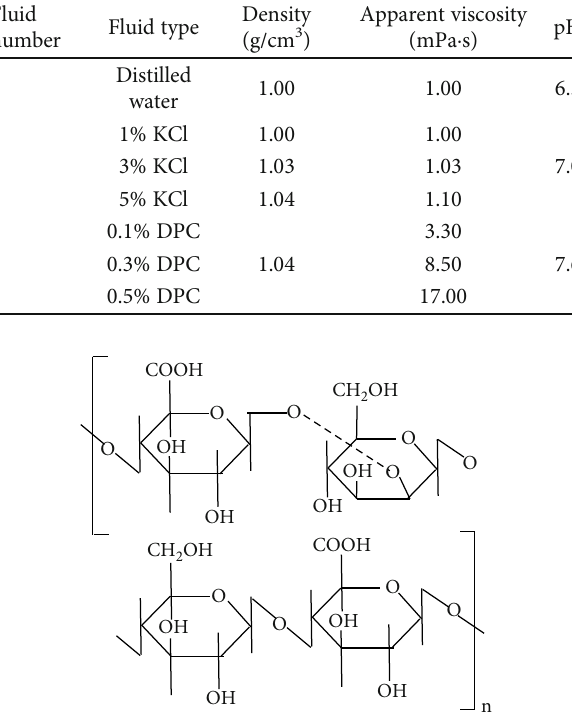
Figure 4: Molecular structure of